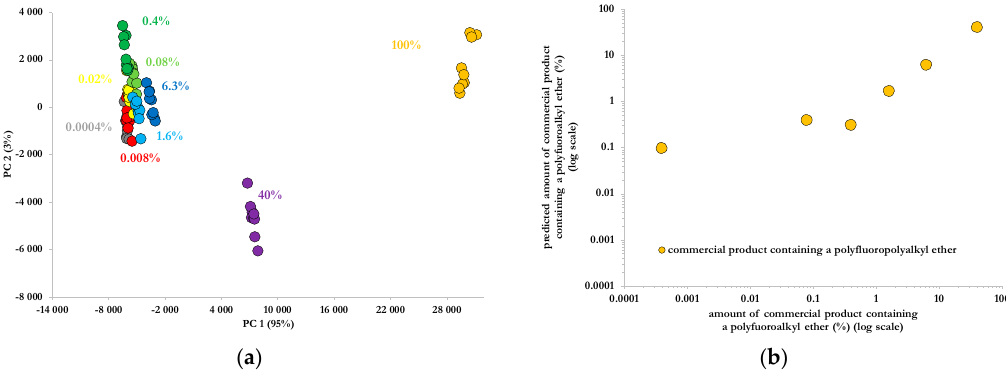
Figure 4. Principle component analysis (PCA) applied to Raman spectra of diluted aqueous solutions of a fire-fighting foam ( a ) and Partial Least Squares (PLS) model to predict the amount of fire-fighting foam Tridol S3B containing a polyfluoroalkyl ether ( b ).